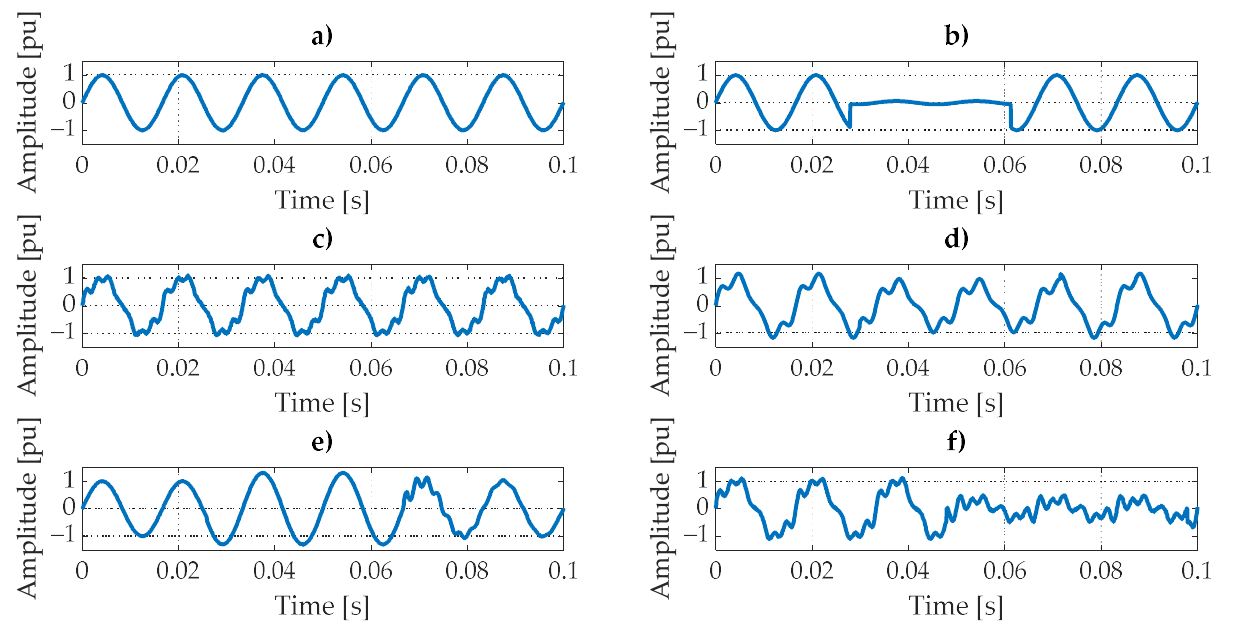
Figure 3. Detail of electrical signals synthetically generated. ( a ) Normal with SNR of 40 dB; ( b ) Interruption noiseless; ( c ) Harmonics with SNR of 30 dB; ( d ) Sag with Harmonics with SNR of 50 dB; ( e ) Swell with Oscillatory Transient with SNR of 40 dB; ( f ) Sag with Harmonics and Oscillatory Transient with SNR of 30 dB.